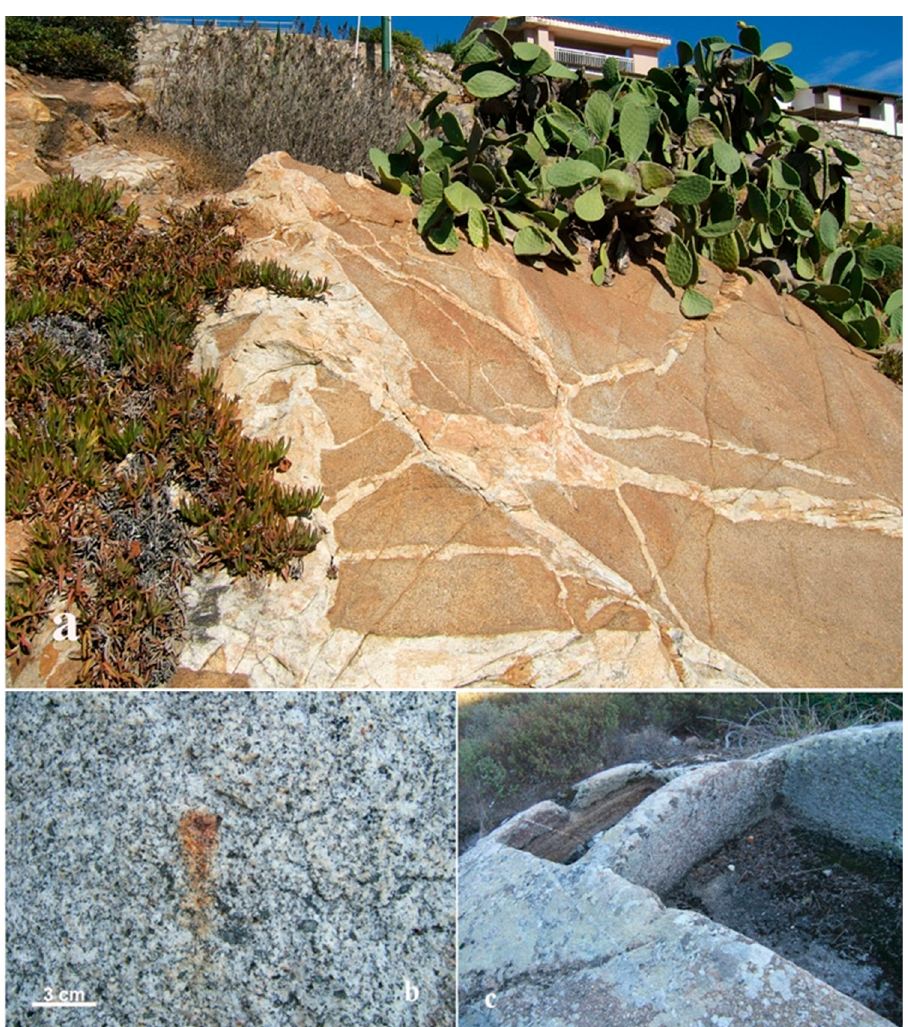
Figure 4. Chromatic alteration of the original grey colour due to oxidation phenomena in a granite outcrop at the base of Giglio Castello city walls. The white veins are the filling by quartz (a); oxidation of a pyrite crystal (b); bio-colonisation in tanks of a palmento , a traditional construction for the processing of grape must (c).